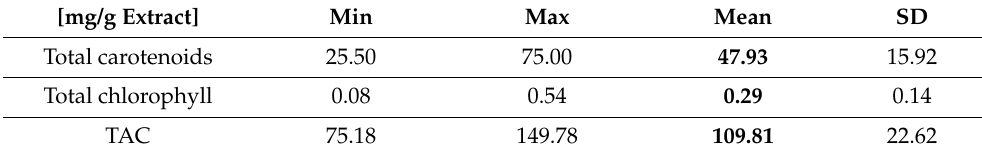
Table 4. The content of pigments, carotenoids, chlorophyll, and anthocyanins in the elderberry extract.